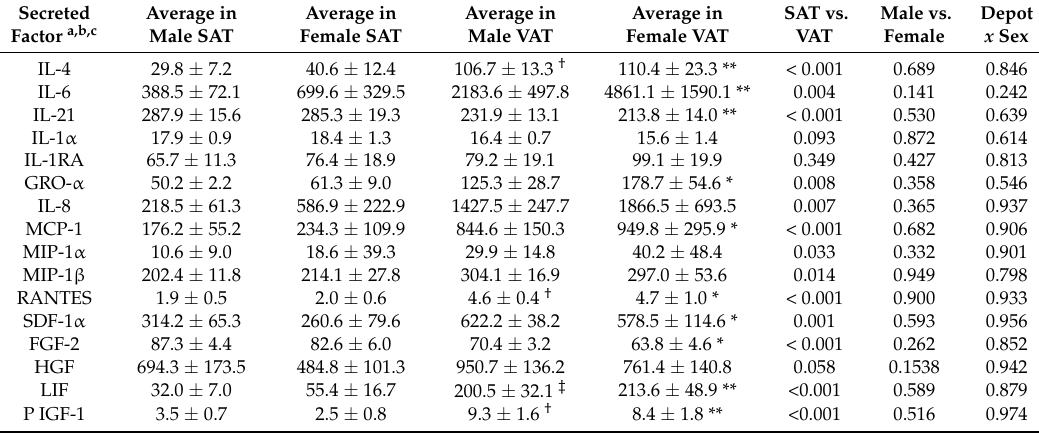
Table 1. Proteins detected in visceral adipose tissue (VAT) and subcutaneous adipose tissue (SAT) secretion media from men and